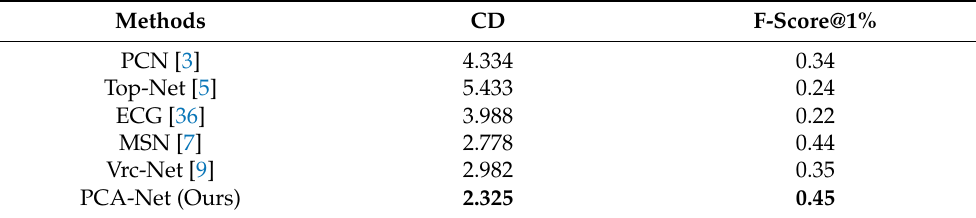
Table 5. Supervised shape completion results ((CD × 10 3 ) and F − Score @1% ) on Modelnet10 point cloud dataset (2048 points).